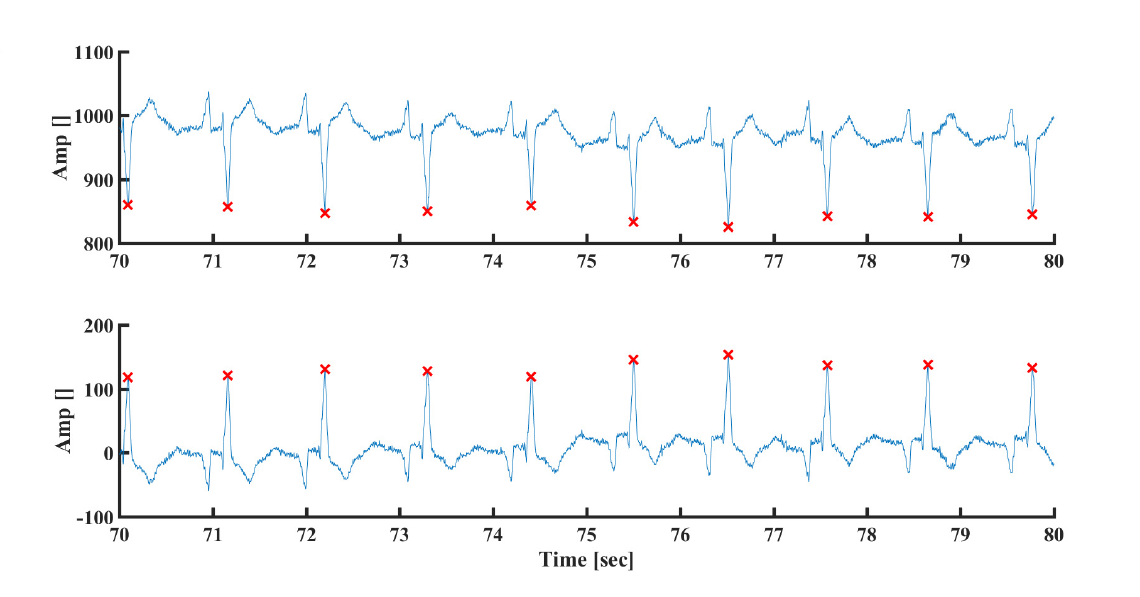
Figure 6. Representative examples of inverse polarity of the ECG signal (A) before and (B) after correction. Data from MIT-BIH Arrhythmia Database #108.